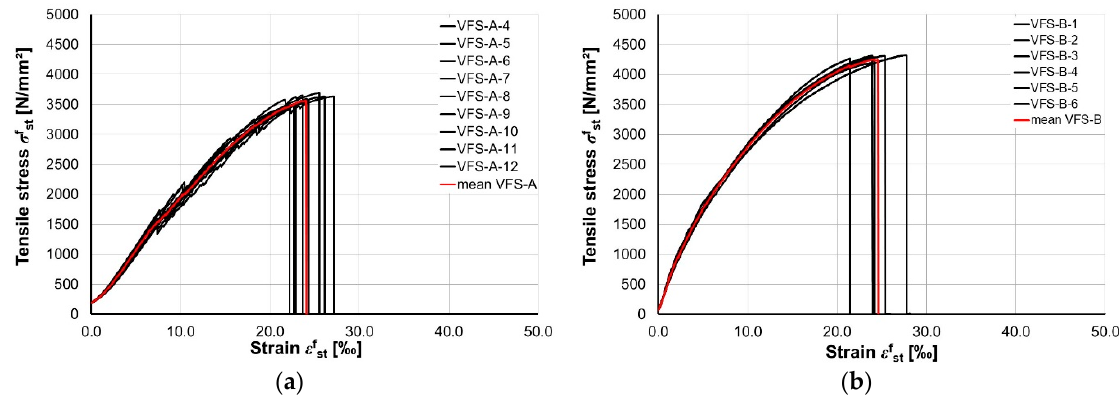
Figure 3. Tensile stress–strain curves of high-strength micro steel fibres of test series VFS-A ( a ) and VFS-B ( b ).